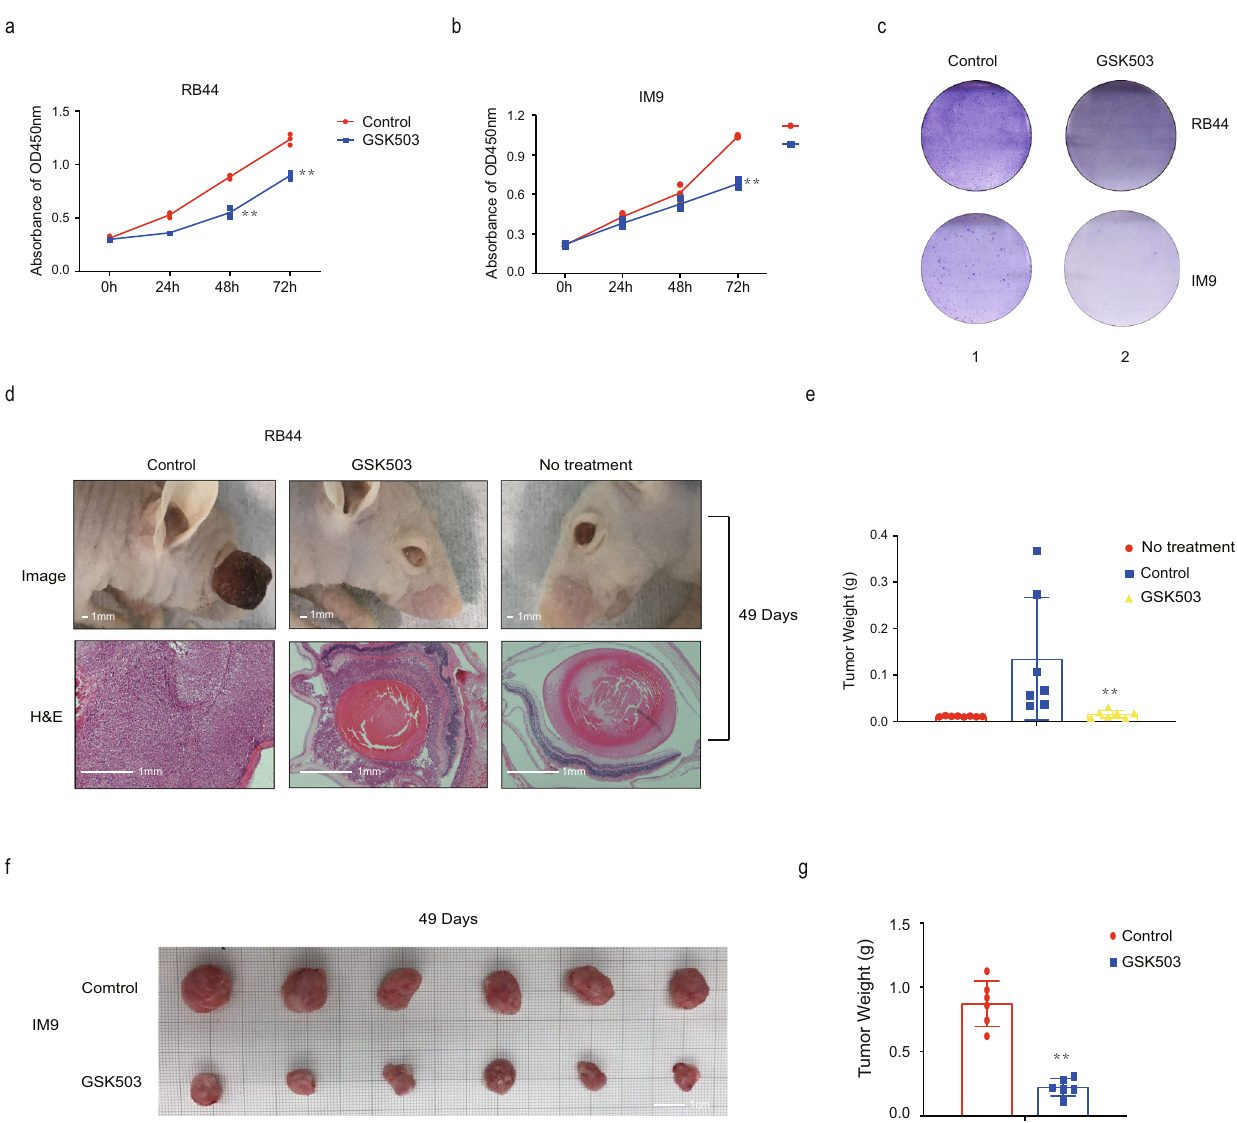
Fig. 6 GSK503 obtains ef fi cient therapeutical effect in RB1 non-mutated tumors. a , b The proliferation ability of RB44 and IM9 cells after GSK503 treatment. ** P < 0.01. c A soft agar colony formation assay was performed to determine the tumor formation ability of RB44 and IM9 cells after GSK503 treatment. d Suppressive effects on tumor volume in the GSK503-treated group in the orthotopic xenograft model. Scale bars: 1 mm. e Suppressive